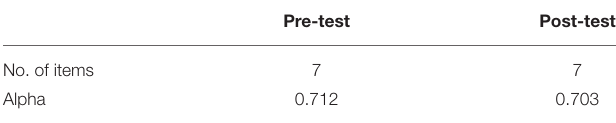
TABLE 2 | Reliability measures for the knowledge tests. TABLE 3 | Reliability measures for the scales in the motivation questionnaire.